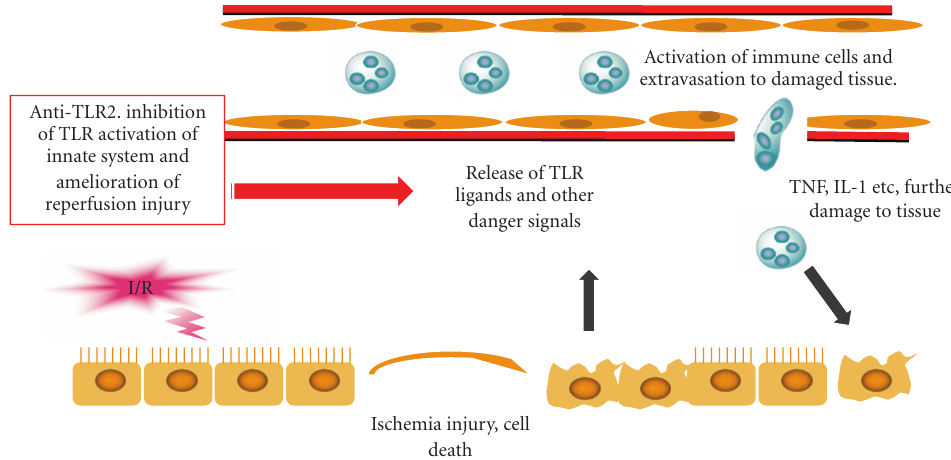
Figure 1: Ischemia–reperfusion injury is characterized by a sublethal injury to epithelial cells resulting in the release of TLR activating danger signals. These danger signals promote the production of chemokines, cytokines, oxygen free radicals and the extravasation of leucocytes from the circulation that amplifies cell damage. Compounds which block TLR activation represent a novel therapeutic mechanism to inhibit this pro-inflammatory cascade thus reducing I/R damage and improving organ